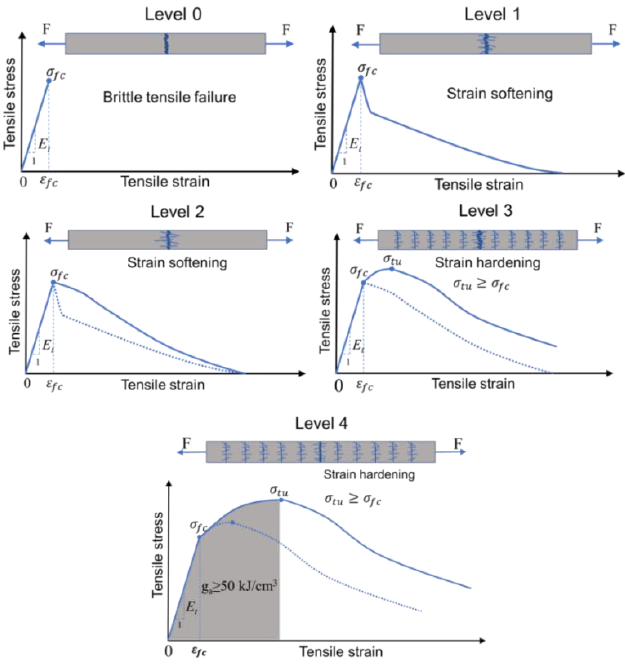
Figure 13 . Evaluation of tensile performance grade of UHPC [32]. Figure 13. Evaluation of tensile performance grade of UHPC